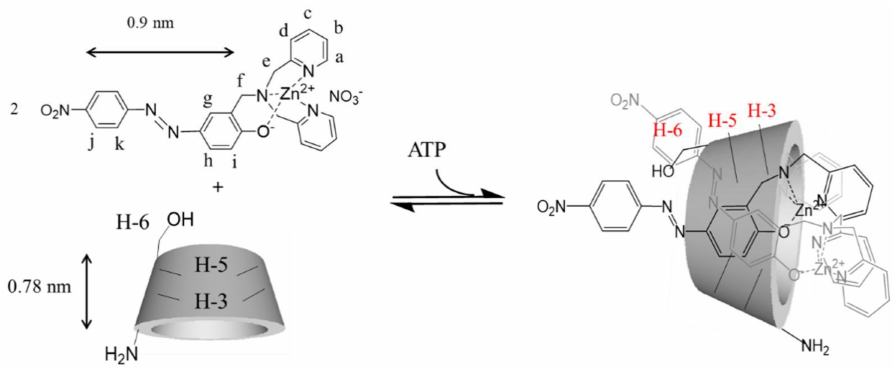
Scheme 1. Suggested conformation of 1-Zn and 3-NH 2 - γ -CyD in the presence of